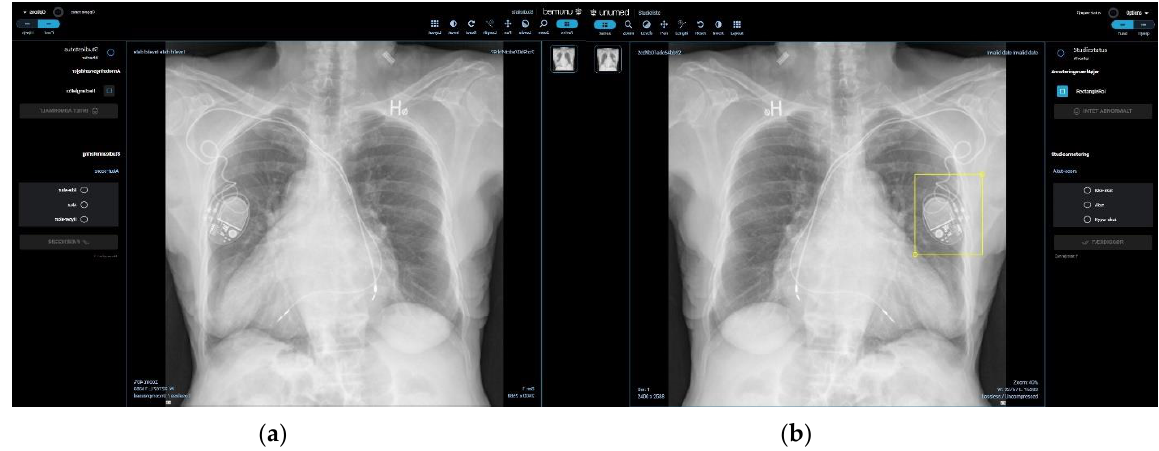
Figure 2. Image representations of the annotation software interface. ( a ) Front page layout of the annotation software and ( b ) bounding box for annotation of finding in the lower right hemithorax.